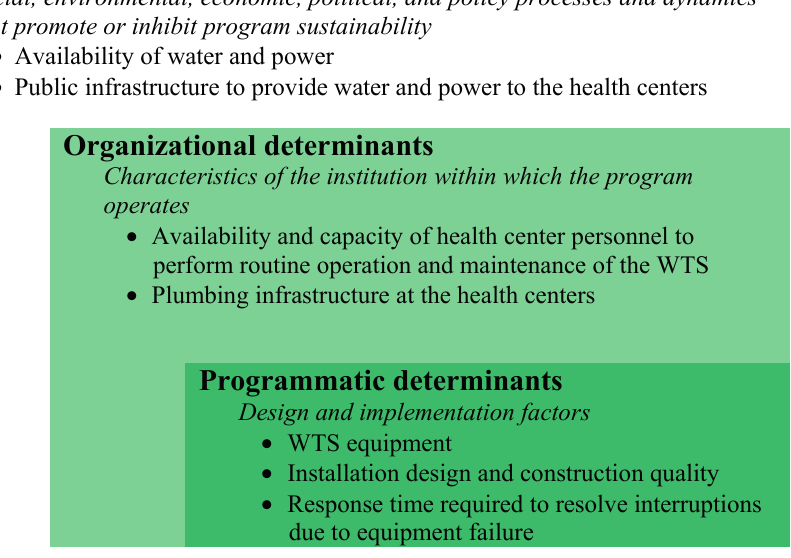
Figure 3. Determinants of water treatment system performance derived from sustainable health services delivery framework *. (* Adapted from Sarriot et al. 2004 [34] and Schreier et al. 2011